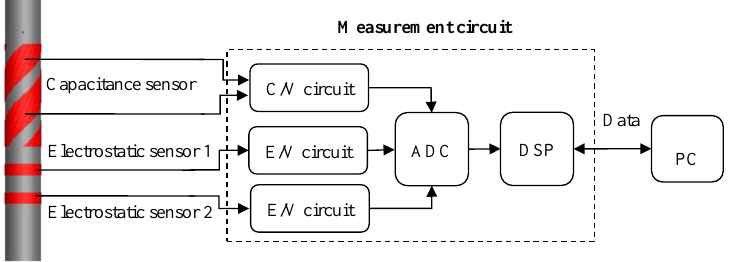
Figure 1. Integrated instrumentation system based on electrostatic and capacitance sensors.